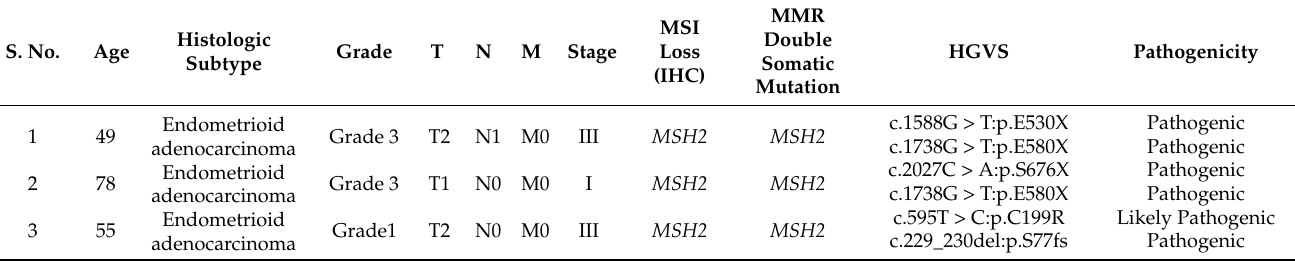
Table 3. Clinicopathological details of the three Lynch-like syndrome cases.